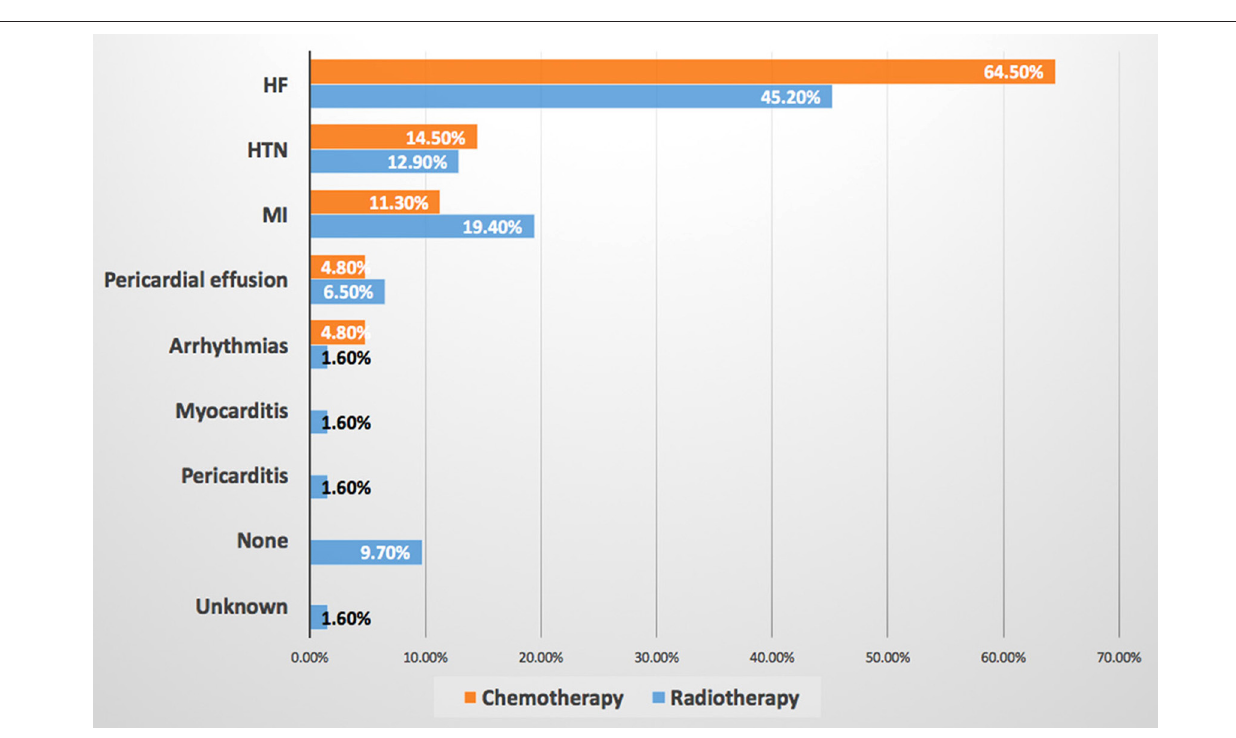
Frontiers in Cardiovascular Medicine |